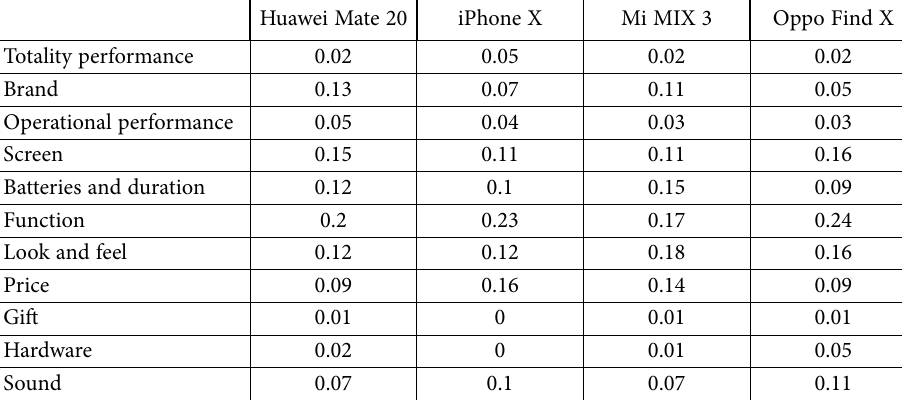
Table 5. Weight matrices of the 11 attributes for four phones on